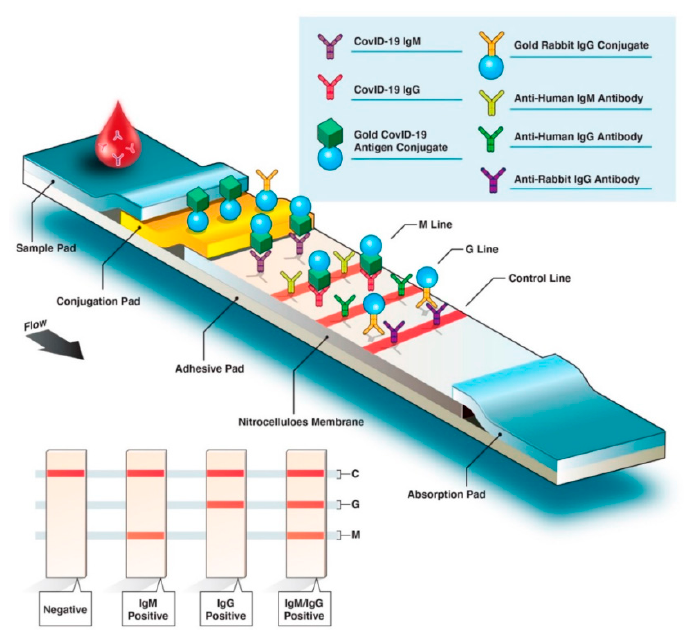
Figure 4. COVID-19 rapid serological IgM/IgG test. Reprinted with permission from Ghaffari, A. et al. COVID-19 Serological Test: How Well Do They Actually Perform? Diagnostics 10(7): 453. Copyright (2020) MDPI [221].